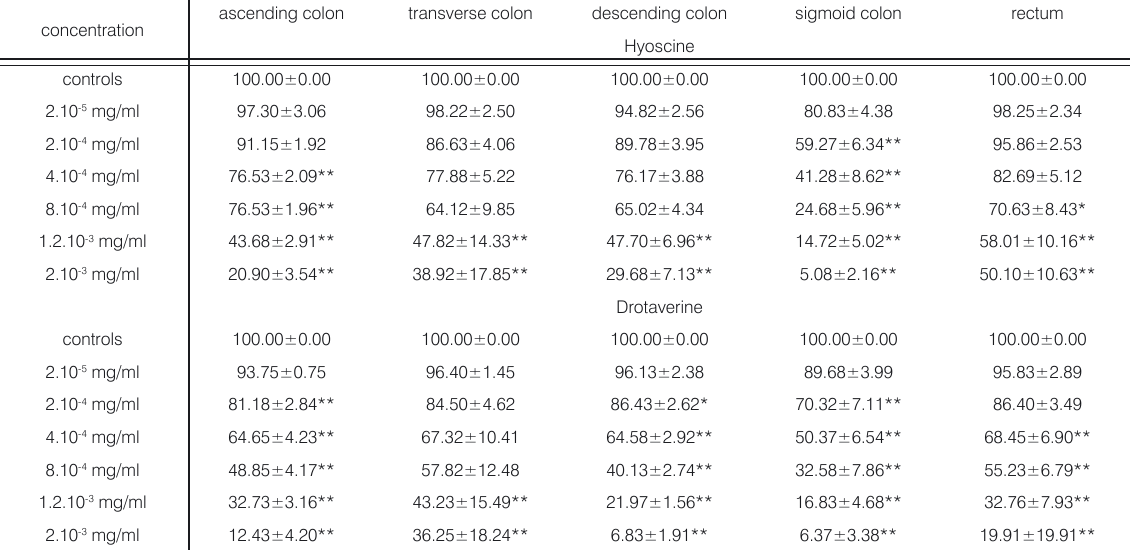
Table 3. Influence of hyoscine and drotaverine on the strength (amplitude) of spontaneous contractions of SM preparations from ascending colon, transverse colon, descending colon, sigmoid colon and rectum. The comparisons were made with reference to the initial values of the amplitudes from each area of the colon, given as 100% for each medication individually. * P < 0.05; ** P < 0.01.